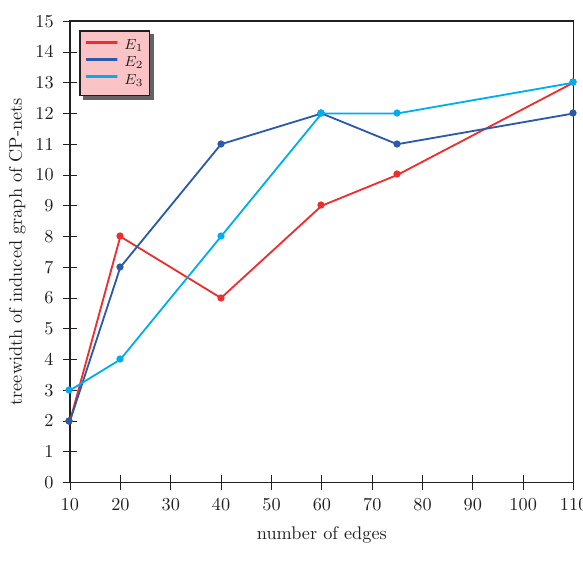
Figure 10. Treewidth corresponding to different edges in a given induced graph with 16